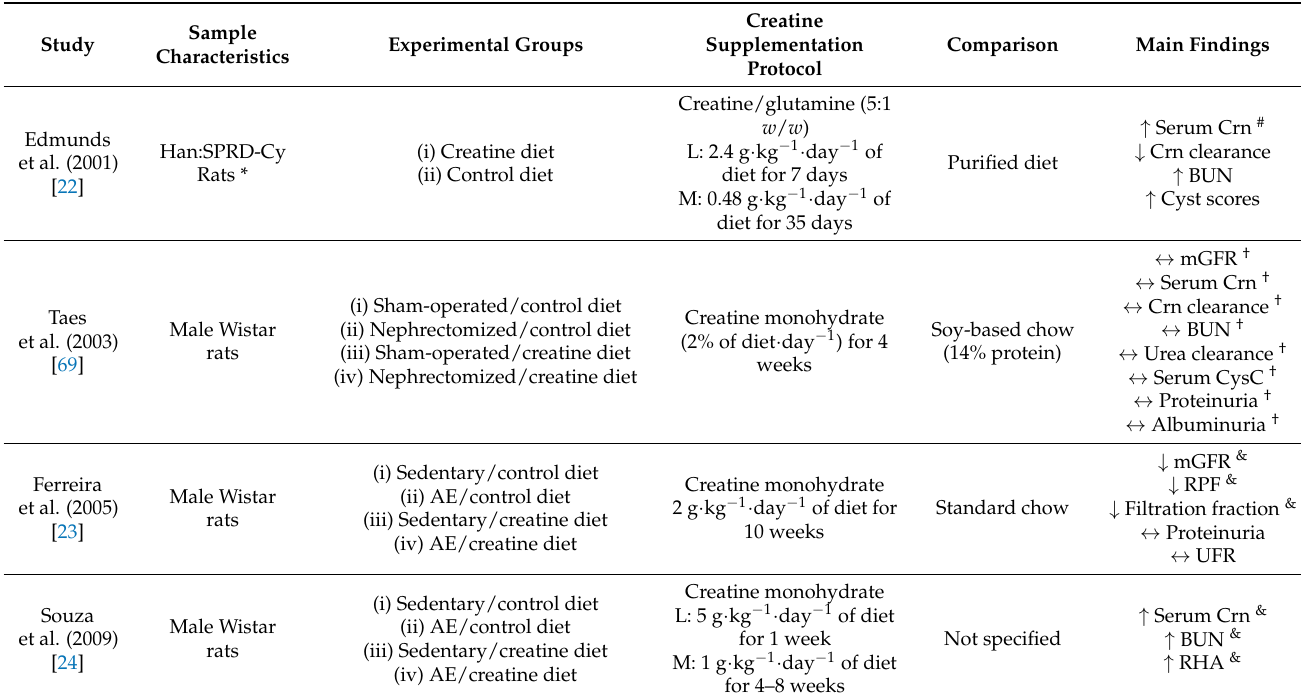
Table 1. Experimental studies investigating the effect of creatine supplementation on kidney function in